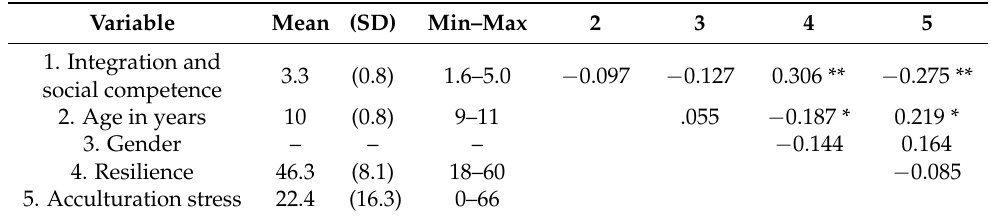
Table 2. Means, standard deviations, and correlations between the study variables in the pri- mary sample.